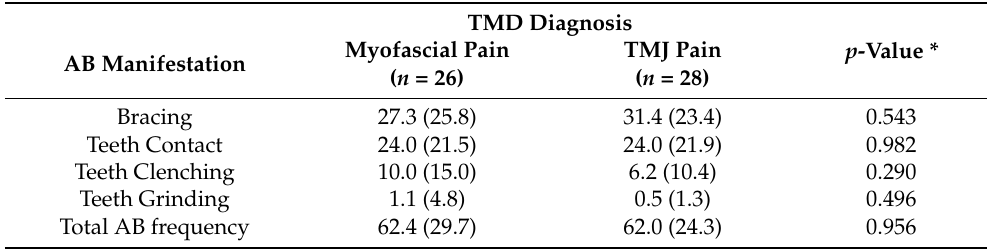
Table 2. Mean (SD) values of each AB manifestation considering muscle TMD only or joint TMD associated with/without muscle